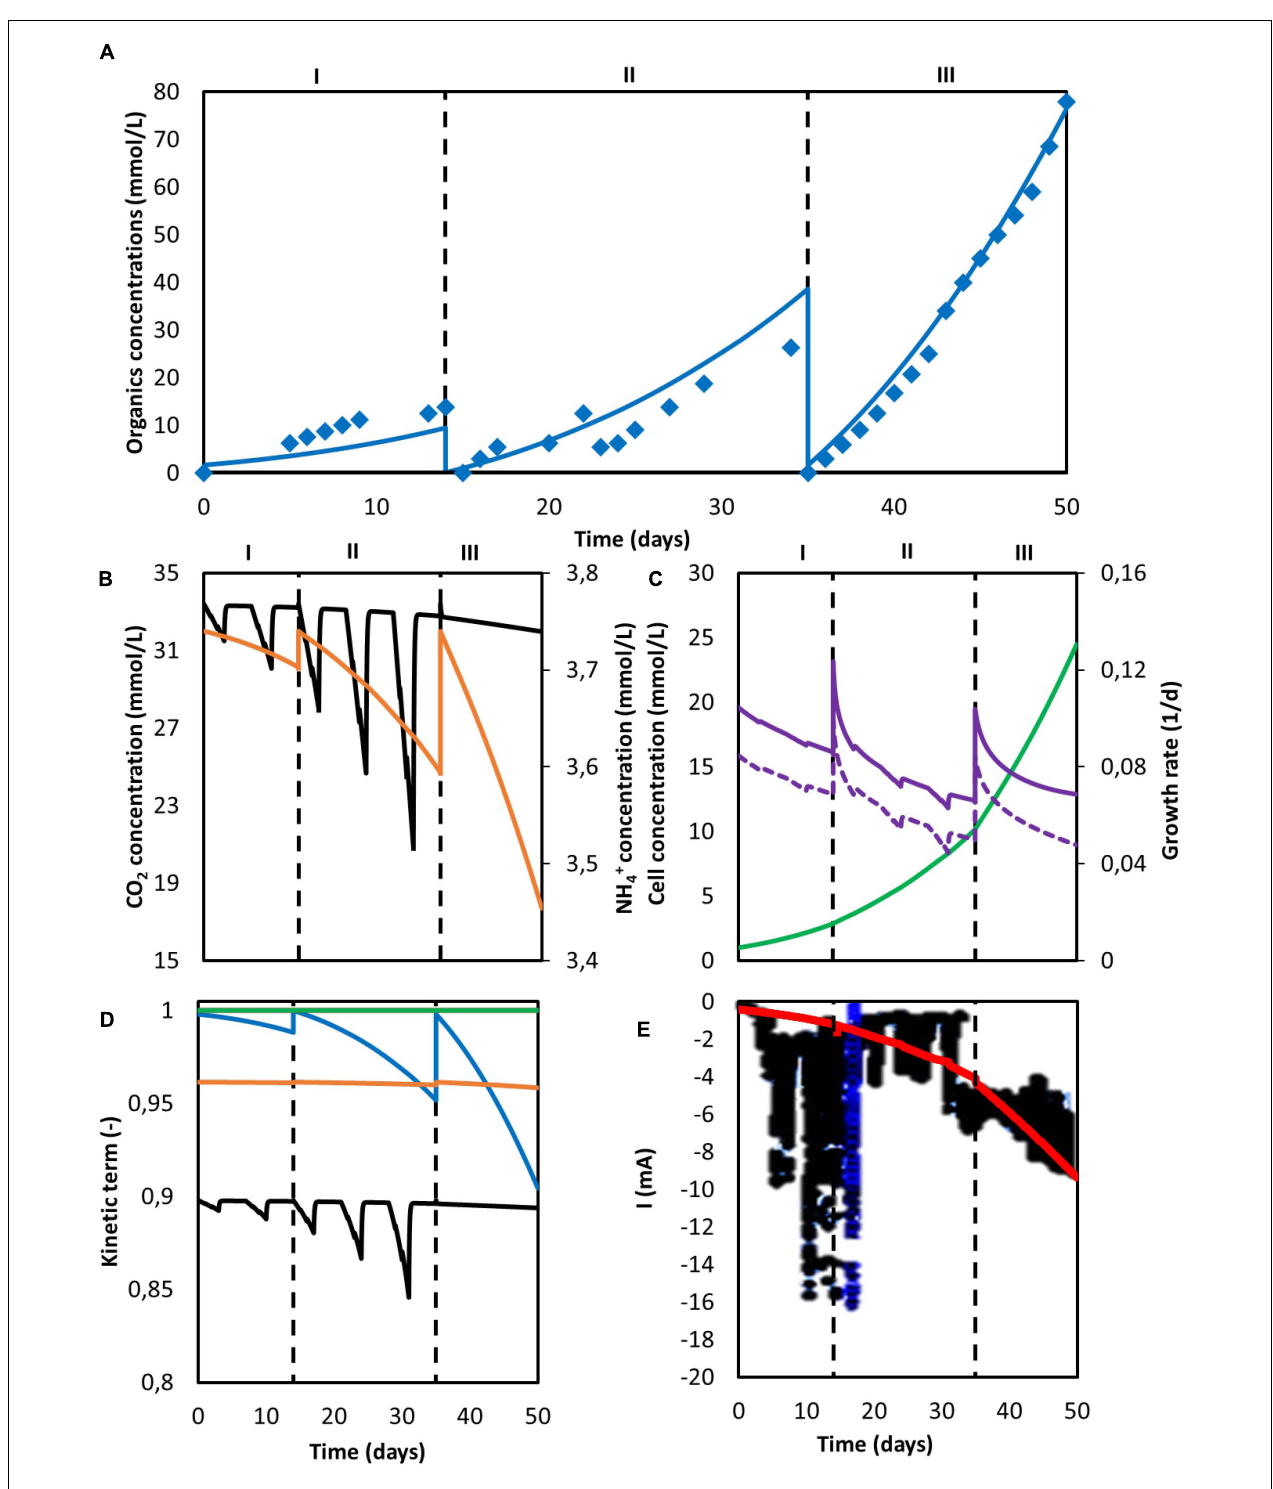
FIGURE 5 | Computed simulation results of a MES system with three consecutive batches. (A) Predicted concentration of acetate (blue line) and experimentally determined acetate concentration from Marshall et al. (2013) (blue diamonds); (B) Concentration of CO 2 (black) and NH 4 + (orange); (C) Microbial cell concentration (light green), calculated maximum growth rate (purple), and growth rate (purple dashed line); (D) Kinetic hyperbolic uptake terms of CO 2 (black) and NH 4 + (orange), and kinetic product inhibition term of acetate (blue); (E) Predicted (red) and experimental (black) current. The vertical dashed lines represent the three different batch